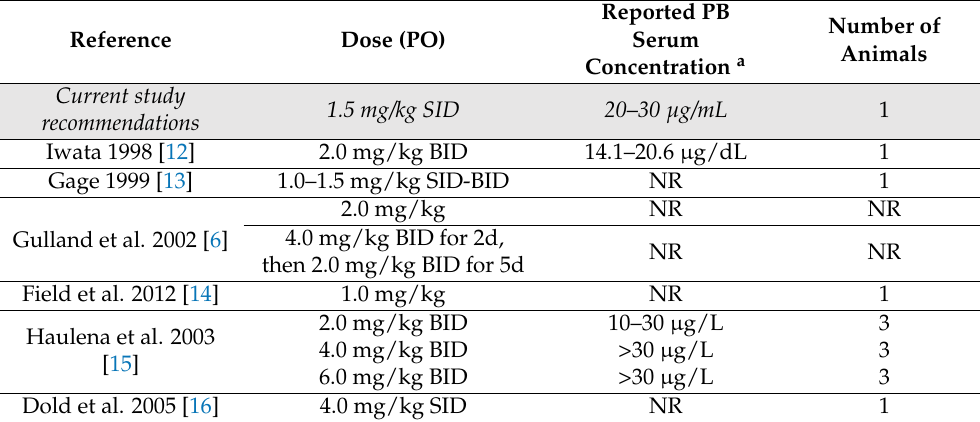
Table 1. Published oral phenobarbital dosing and serum phenobarbital concentrations in California sea